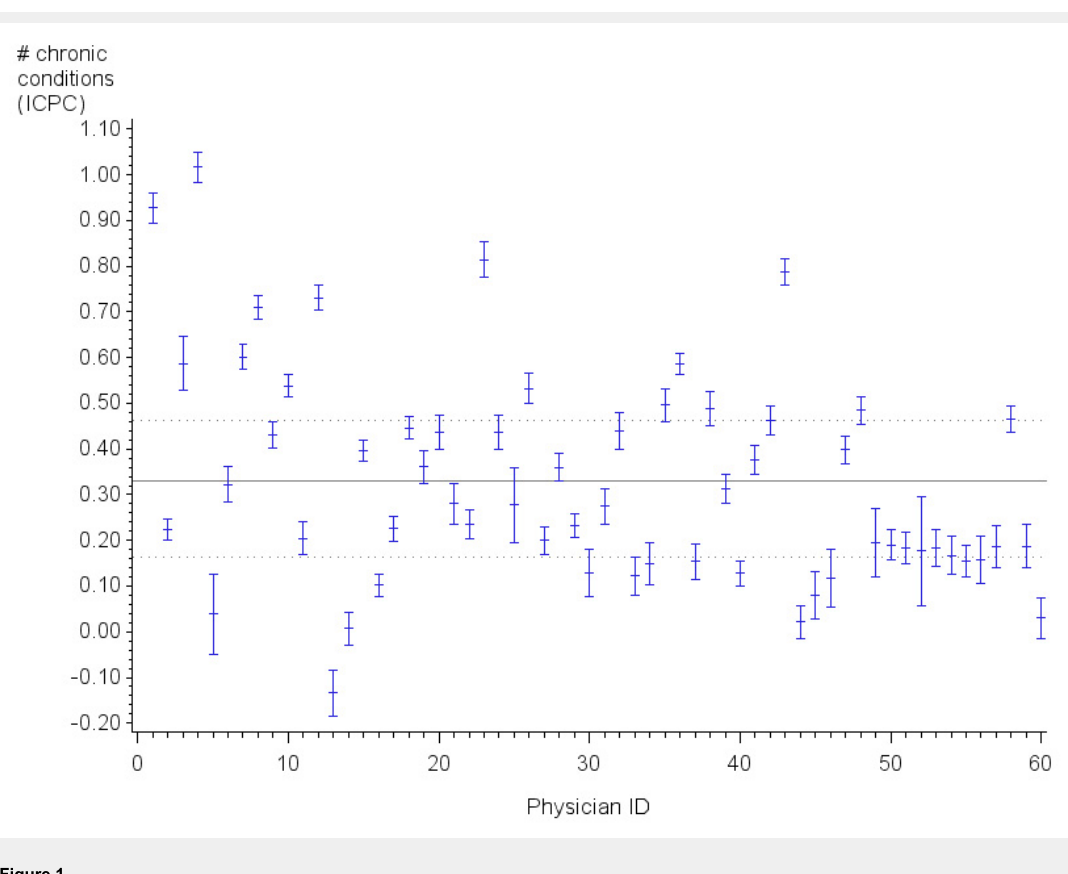
Variation of average number of ICPC based chronic conditions per patient across 60 primary care practices. a The horizontal line denotes the overall averages of ICPC codes at the practice level, dotted lines the first and third quartile. Error bars show the 95% confidence interval of ICPC based morbidity estimates of